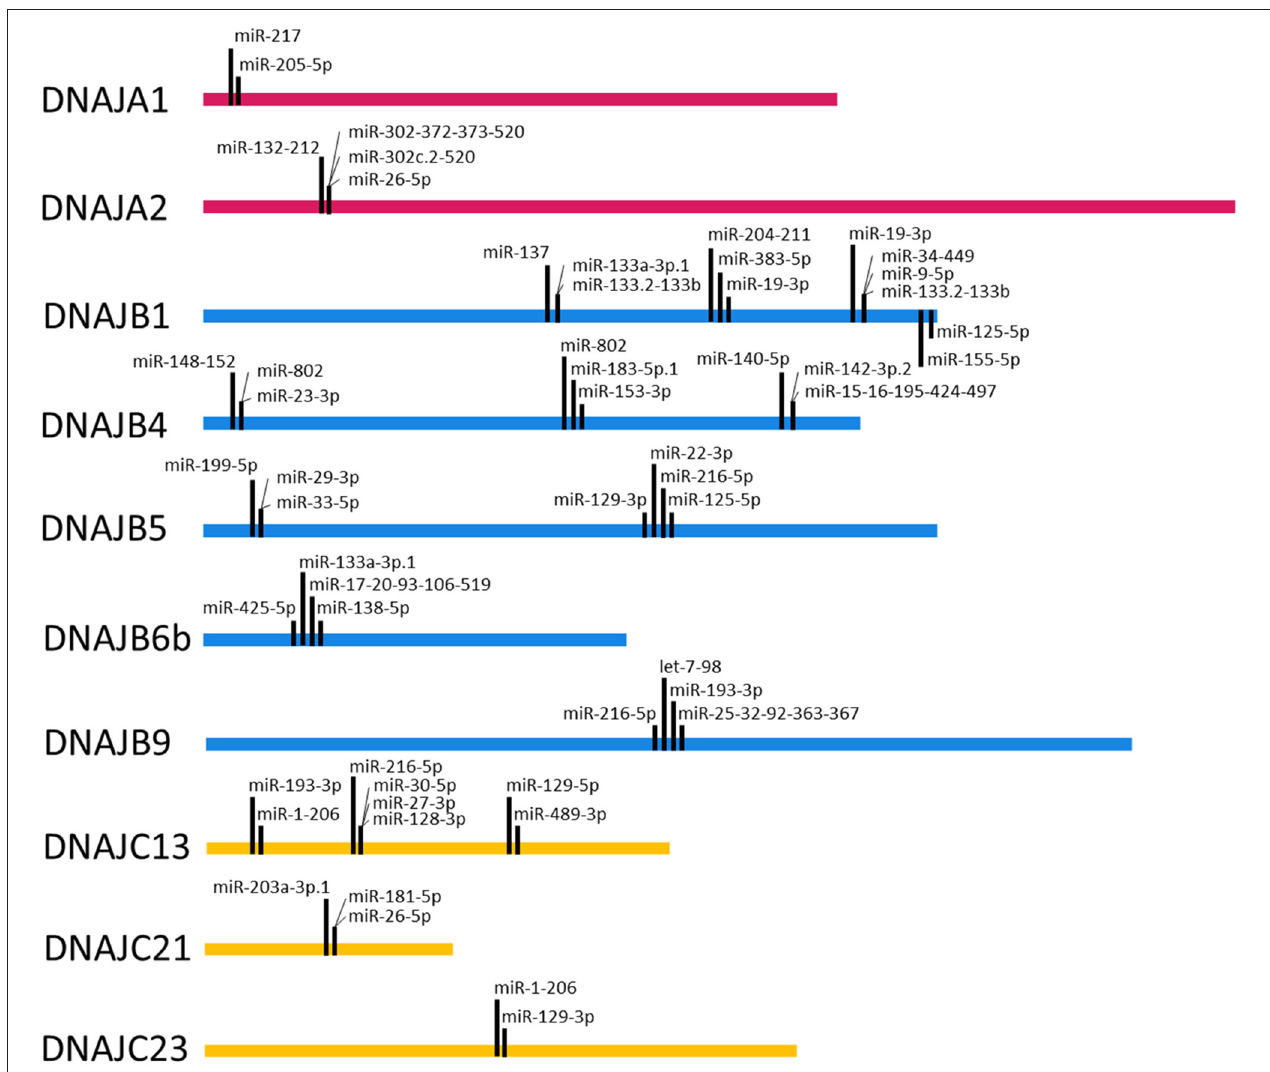
FIGURE 4 | Target Site Proximity. For each J-Protein, target sites were identified on TargetScan (Agarwal et al., 2015) with a context score of < − 0.1 and then manually scanned for the occurrence of miRNA seed sequences < 40 nucleotides apart. The locations of identified close proximity target sites are visualized on the ribbon corresponding to the nucleotide length of the 3’ UTR for each given J-Protein. Only miRNA families that are broadly conserved through vertebrates were included in the analysis.